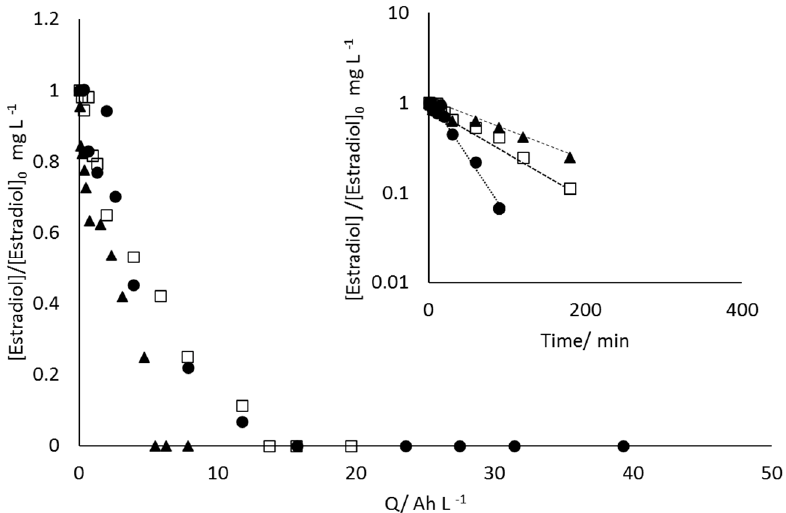
Figure 2. Changes in the concentration of 17 β -estradiol during the electrolysis of synthetic urine/methanol system with BDD anodes at different current densities and at 6.77 mL·s − 1 of flowrate. Current density: ( ▲ ) 20 mA·cm − 2 ; ( □ ) 50 mA·cm − 2 ; ( ● ) 100 mA·cm − 2 .